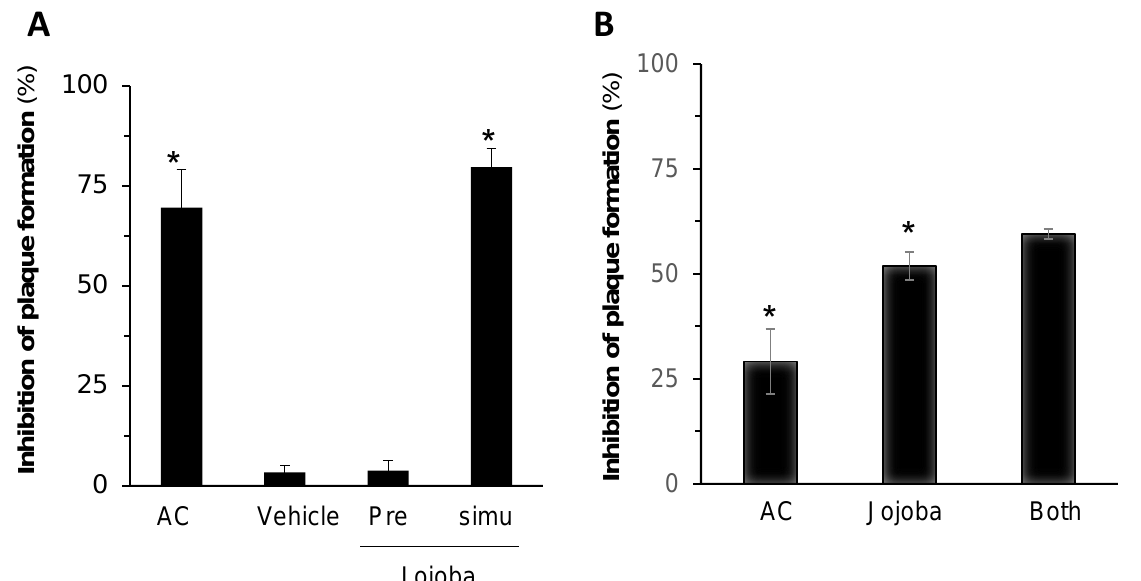
comparison to the infected control. AC-acyclovir. the infected control. AC-acyclovir.